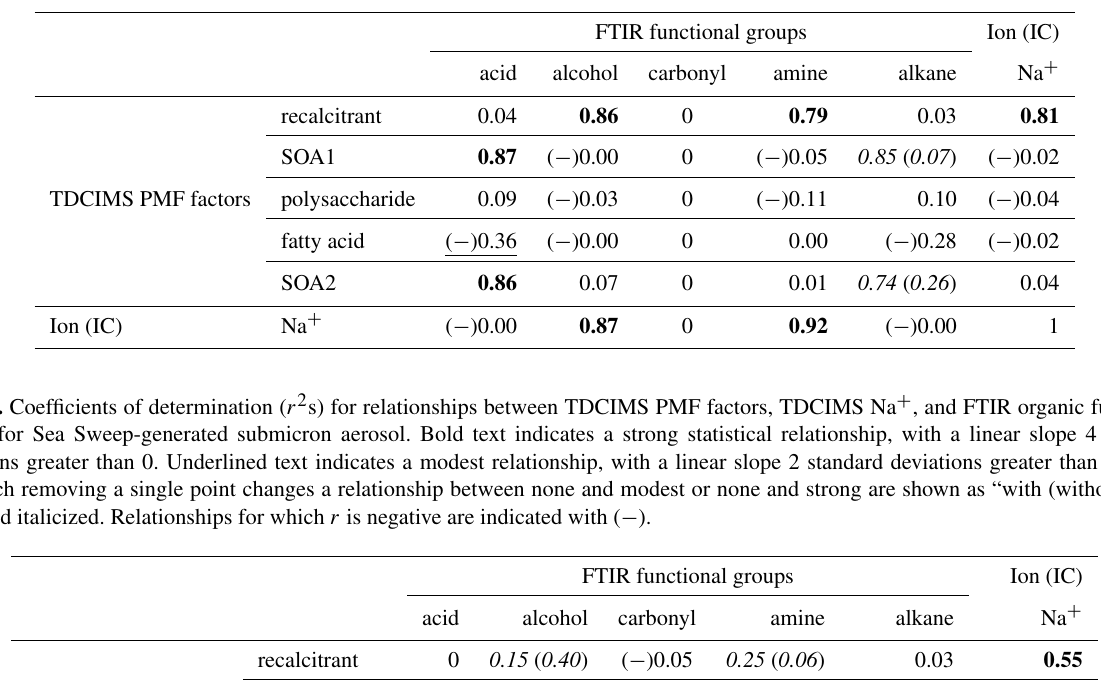
Table 1. Coefficients of determination ( r 2 s) for relationships between TDCIMS PMF factors, Na + , and FTIR organic functional groups for ambient submicron aerosol characterized as marine. Bold text indicates a strong statistical relationship, with a linear slope 4 standard deviations greater than 0. Underlined text indicates a modest relationship, with a linear slope 2 standard deviations greater than 0. Cases for which removing a single point changes a relationship between none and modest or none and strong are shown as “with (without)” that point and italicized. Relationships for which r is negative are indicated with ( − ).